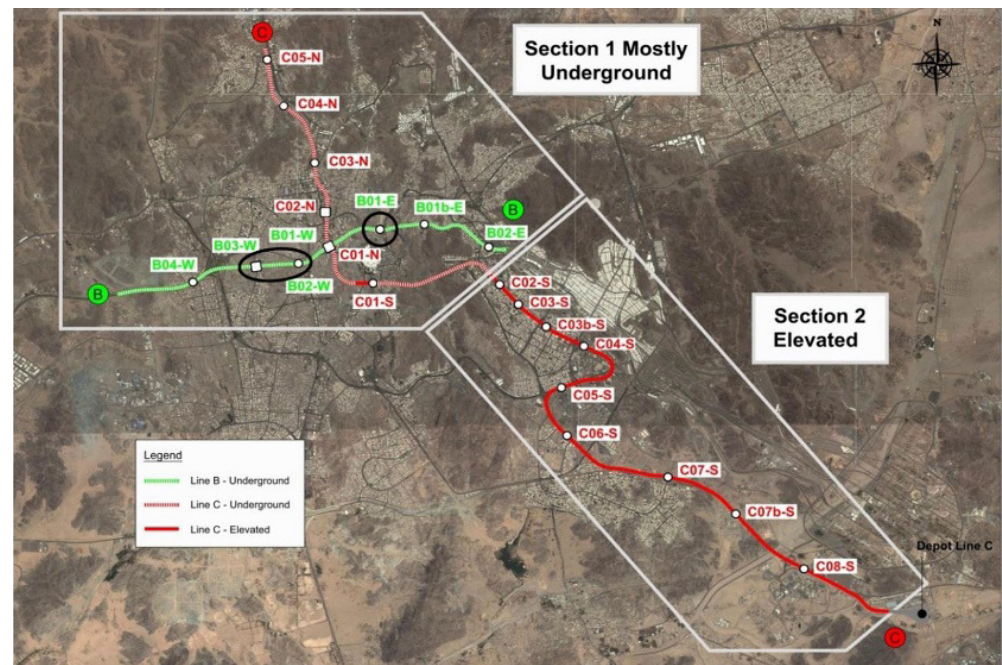
Figure 2. The Mecca Metro map consists of four lines and the public transport is operated by Mecca Mass Rail Transit Company. Source: 3TI Progetti